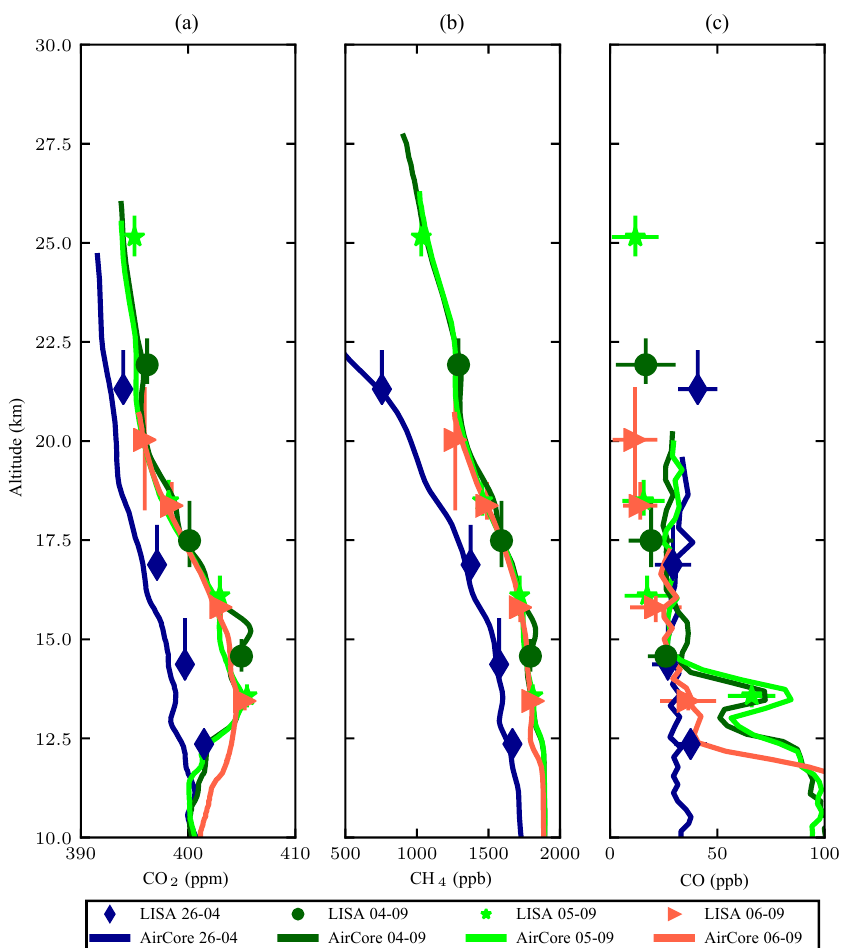
Figure 5. Comparison of AirCore and LISA measurements of (a) CO 2 , (b) CH 4 and (c) CO mole fractions. The AirCore CO profiles are averaged in 100m bins to smooth the relatively large noise of the measurements due to the analytical precision of 7ppb (1 σ ) of the CRDS analyser. Different colours and symbols are used to label the samples from different flights shown in the legend. All flights were performed in